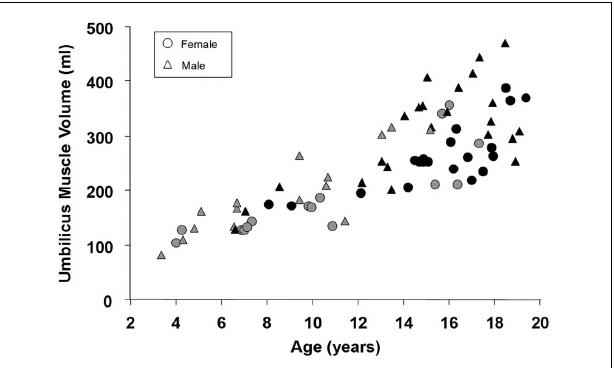
FIGURE 3 | Scatter plot of muscle volume versus age for male and female pediatric patients with (black, BAT + ) and without (gray, BAT − ) visually depicted metabolically active BAT by PET/CT. For males without visualized BAT (gray triangles), the linear correlation coefficient was r = 0.88; for males with visualized BAT (black triangles), the coefficient was r = 0.72; for females without visualized BAT (gray circles), the coefficient was r = 0.85; for females with visualized BAT (black circles), the coefficient was r = 0.78. All correlations were statistically significant with p <